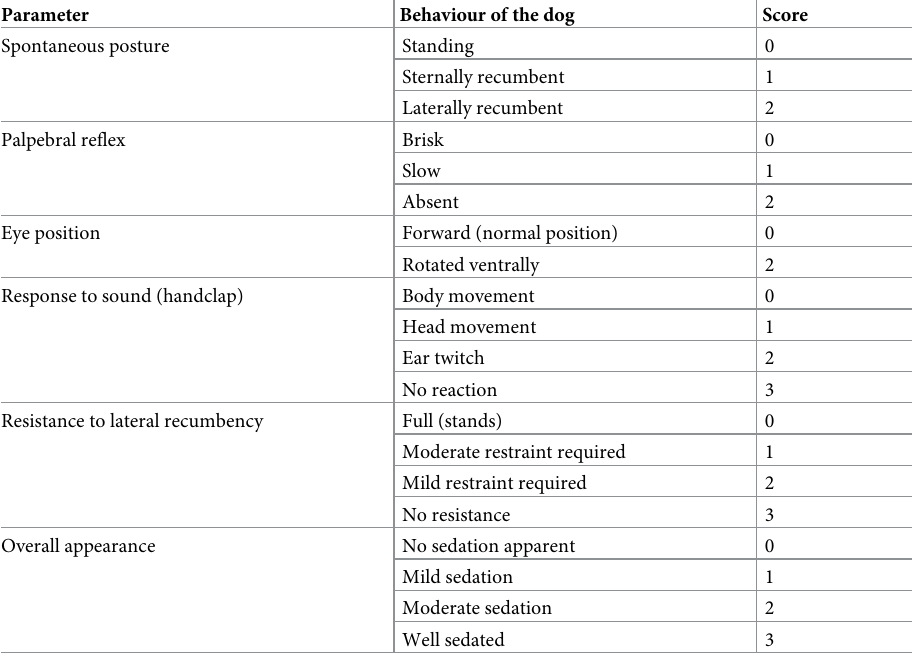
Table 1. Numeric sedation rating scale, adapted from Gurney et al. (2009).